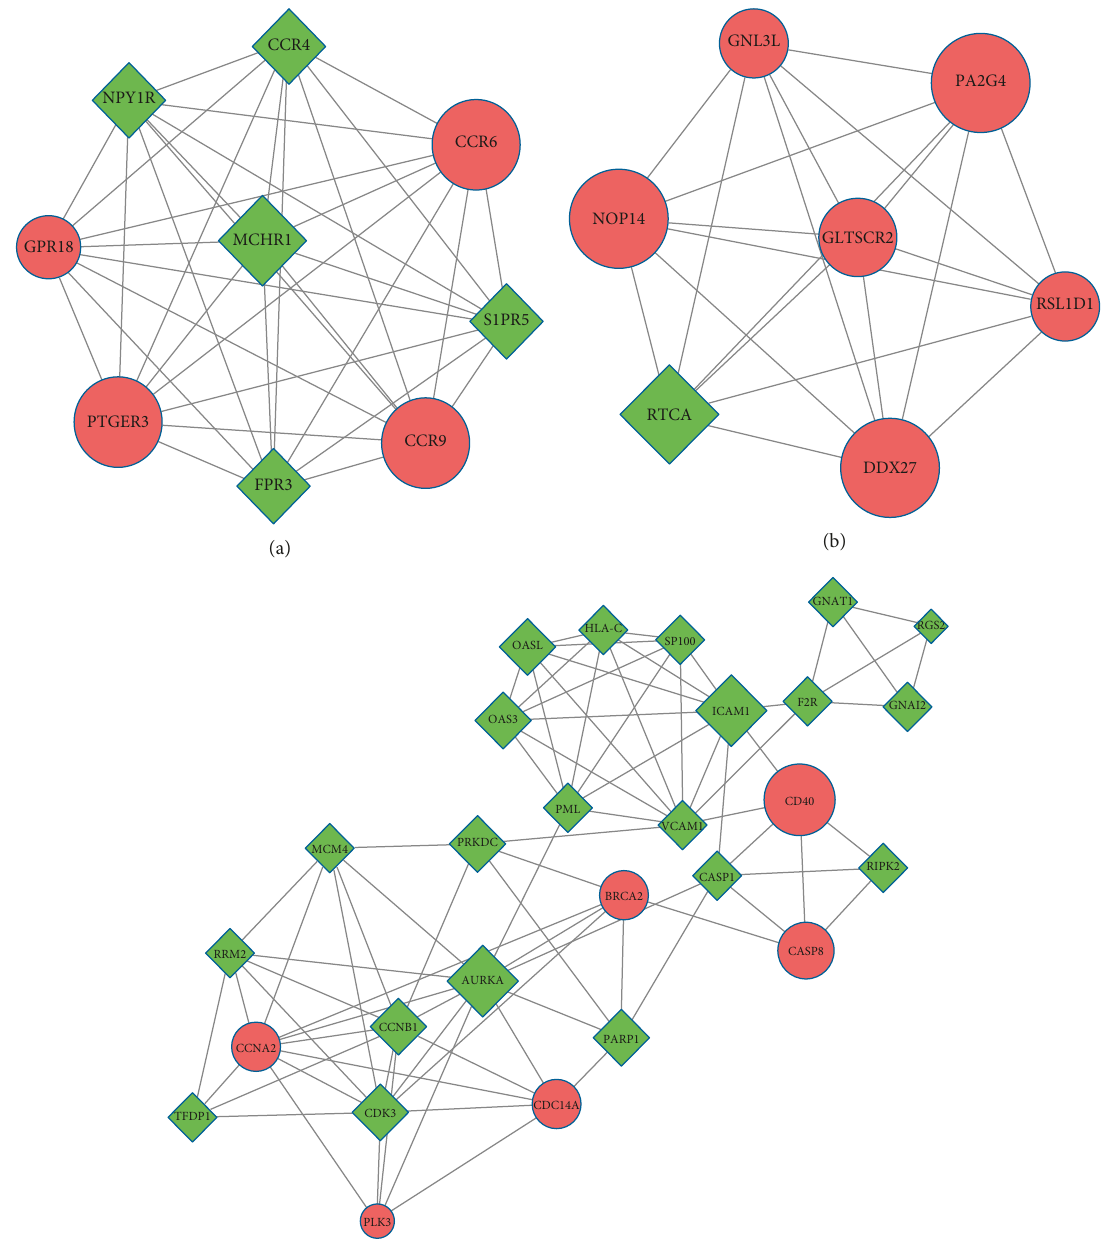
Figure 4: Subnetworks of differentially expressed genes (DEGs). (a) Subnetwork a; (b) subnetwork b; (c) subnetwork c. Red circles represent upregulated DEGs, and green diamonds represent downregulated